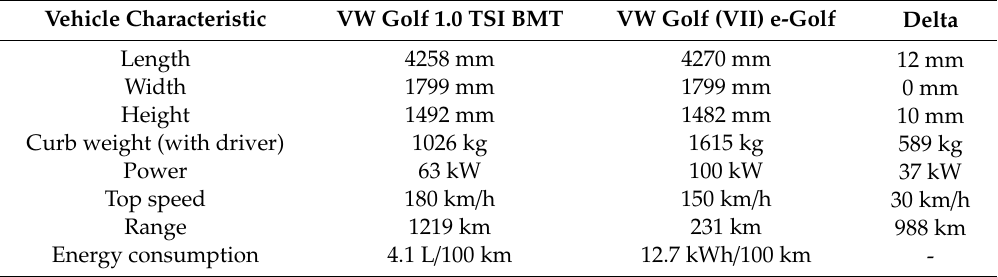
Table 1. Comparison between the internal combustion engine vehicle (ICEV) [5] and the battery electric vehicle (BEV) [5] variants of the Golf model